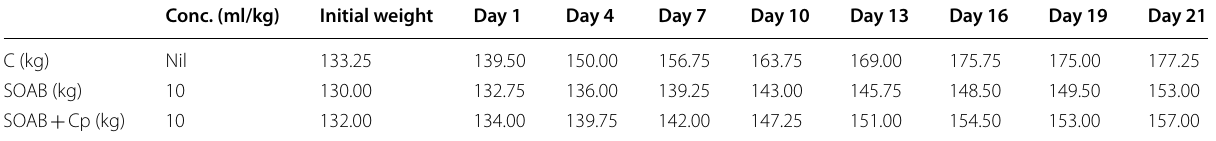
Data are expressed as mean; n